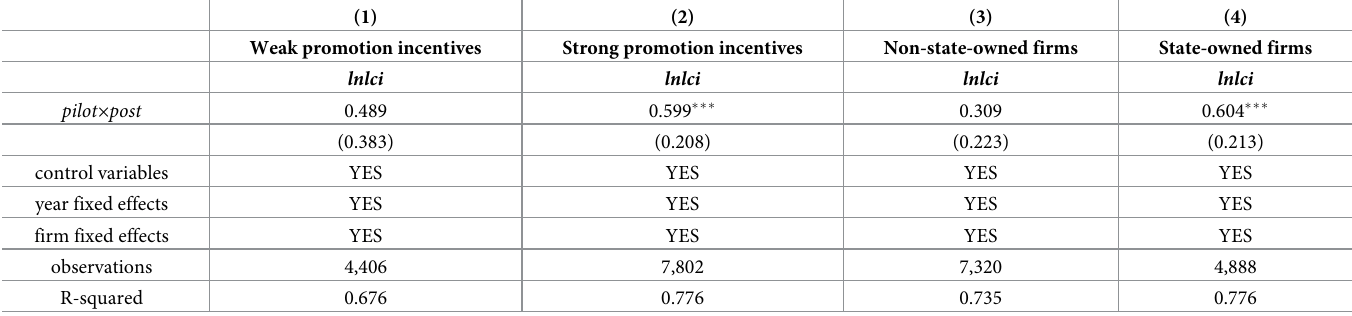
Table 5. Heterogeneity